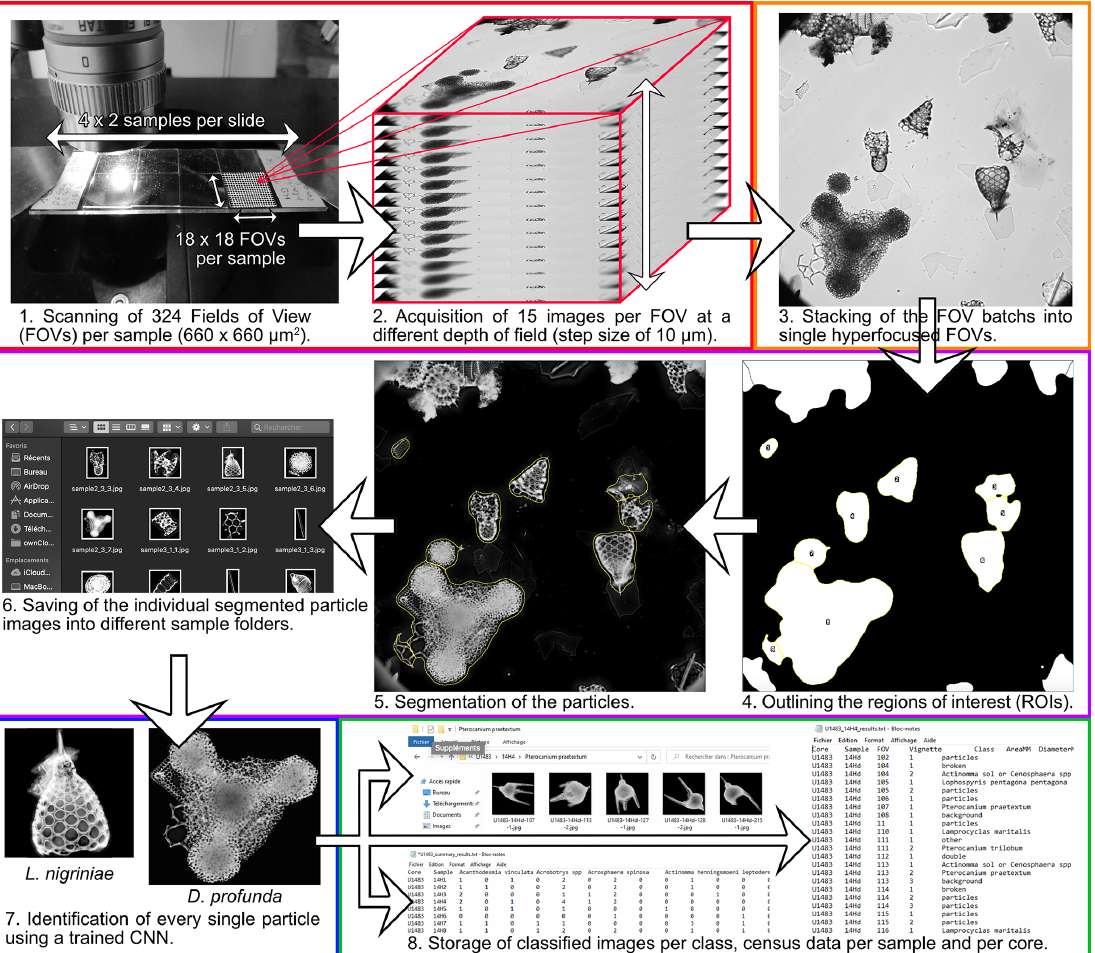
Figure 2. Automated radiolarian image acquisition, processing and identification workflow. Panels 1 and 2 (red rectangle) show the auto- mated acquisition steps. Panel 3 (orange rectangle) shows the automated FOV image stacking step. Panels 4, 5 and 6 (purple rectangle) show the automated FOV image processing and segmentation steps. Panel 7 (blue rectangle) shows the automated recognition step. Panel 8 (green rectangle) shows the automated export of classified images, census counts and morphometric